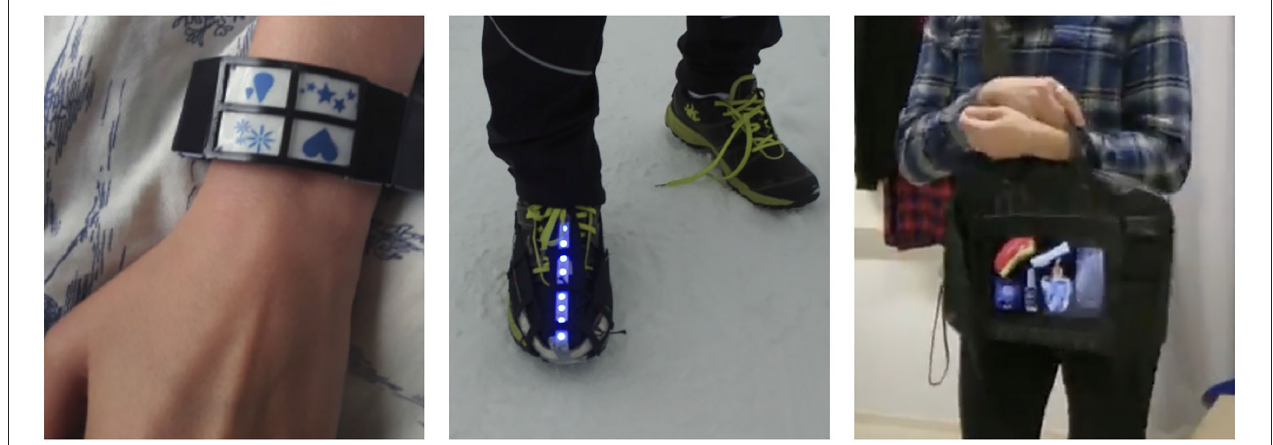
FIGURE 5 | Examples of the authors’ works on smart accessories. L-R: LDR bracelet, smart running shoe, smart handbag displaying the bag’s content on its surface.